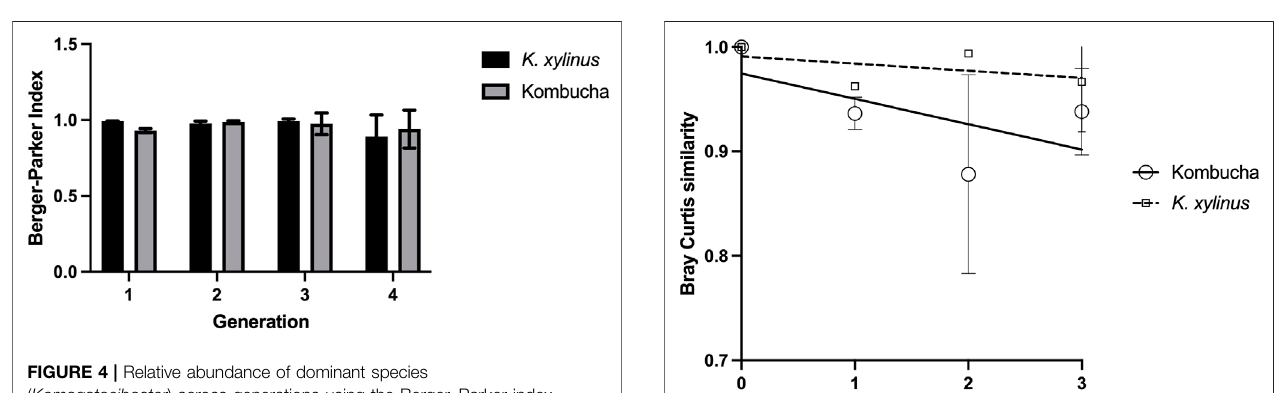
FIGURE 4 | Relative abundance of dominant species ( Komagataeibacter ) across generations using the Berger – Parker index.